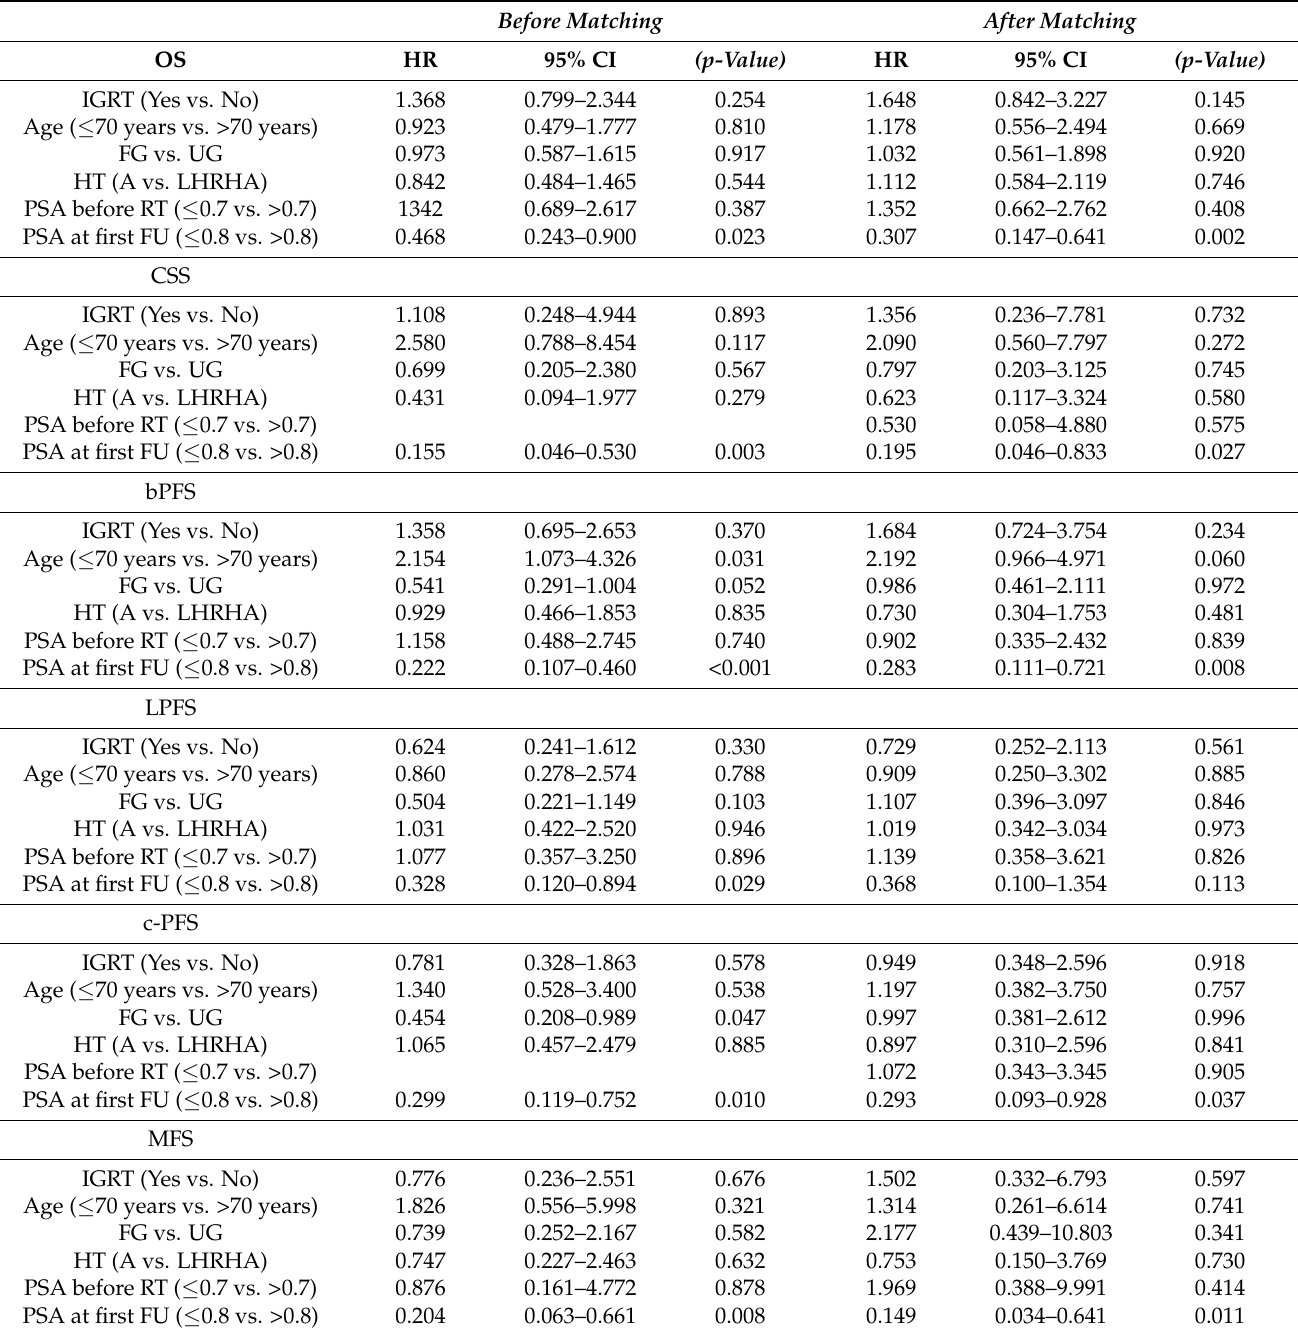
Table 4. Multivariate analysis before and after propensity score